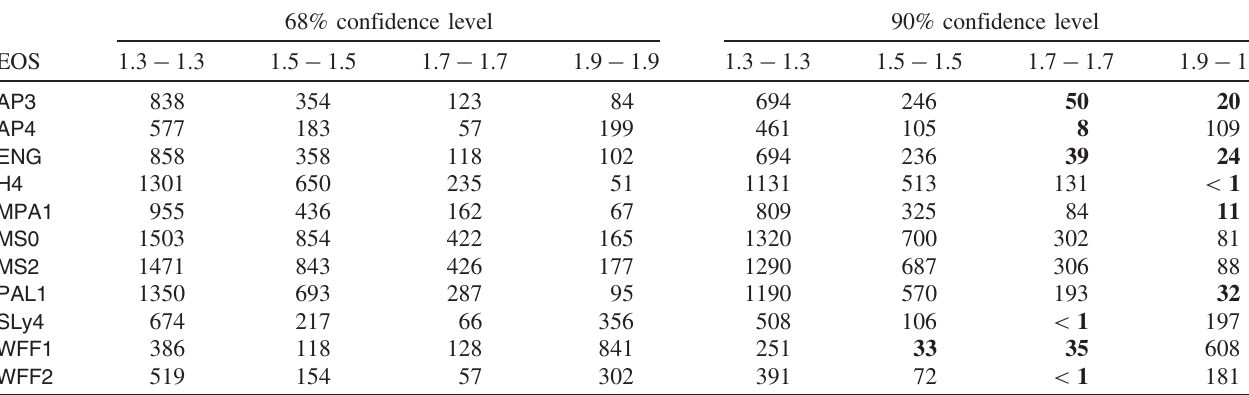
TABLE IV. Frequency f at which dynamical scalarization occurs for various equal-mass binaries, given in Hz. Results are given for DS theories that saturate the constraints given in Table II at 68% and 90% C.L.s. Binary systems are specified by their component NS masses, given in units of M ⊙ . We highlight systems that scalarize at frequencies below 50 Hz with boldface.